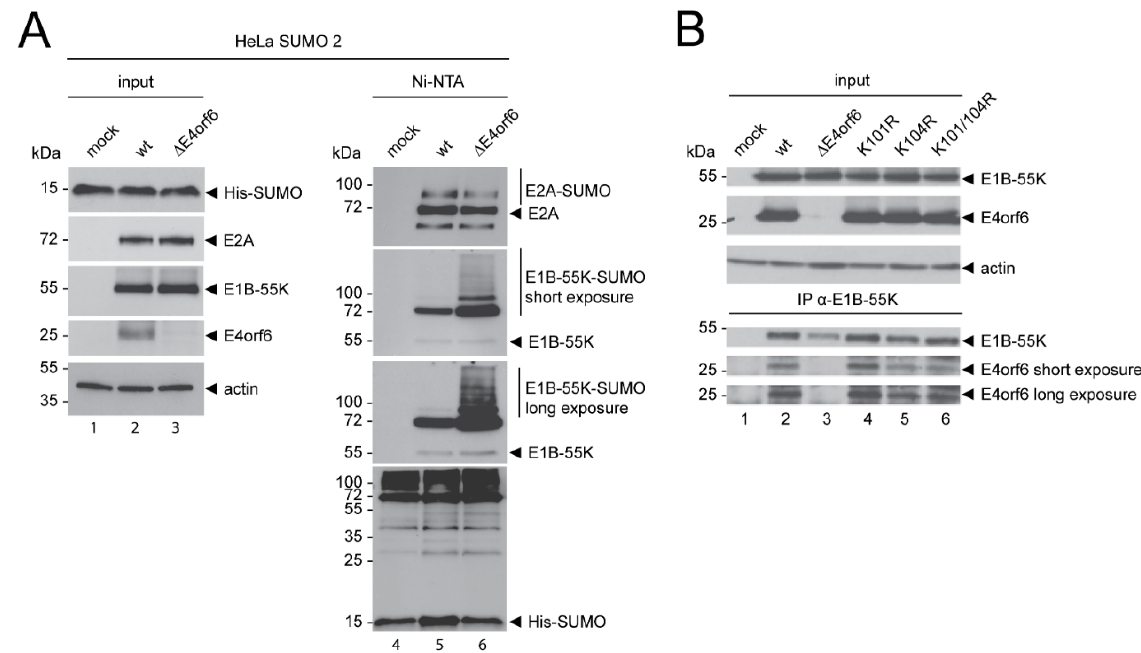
Figure 2. E4orf6 specifically reduces E1B-55K SUMOylation, which does not affect binding to E4orf6. ( A ) HeLa cells that constitutively express His-tagged SUMO 2 were mock infected or infected at an MOI of 20 with HAdV-C5 wt or HAdV-C5 ∆ E4orf6. The cells were harvested at 24 h p.i. and His-SUMO 2 conjugates were subjected to Ni-NTA purification. ( B ) A549 cells were infected with the HAdV-C5 wt and indicated virus mutants at an MOI of 20 and harvested at 24 h p.i for an E1B-55K IP using the 2A6 mouse mAb. Total cell lysates were prepared in parallel (input). Proteins were separated by SDS-PAGE according to their molecular weight and subjected to Western blotting. Proteins were detected using mAb 2A6 (E1B-55K), mAb RSA3 (E4orf6), mAb B6-8 (E2A), mAb 6×His (SUMO 1/2), and mAb AC-15 (actin). Molecular weights in kDa are indicated on the left, while corresponding proteins are labeled on the right. Images represent the results of >3 repeated experiments.